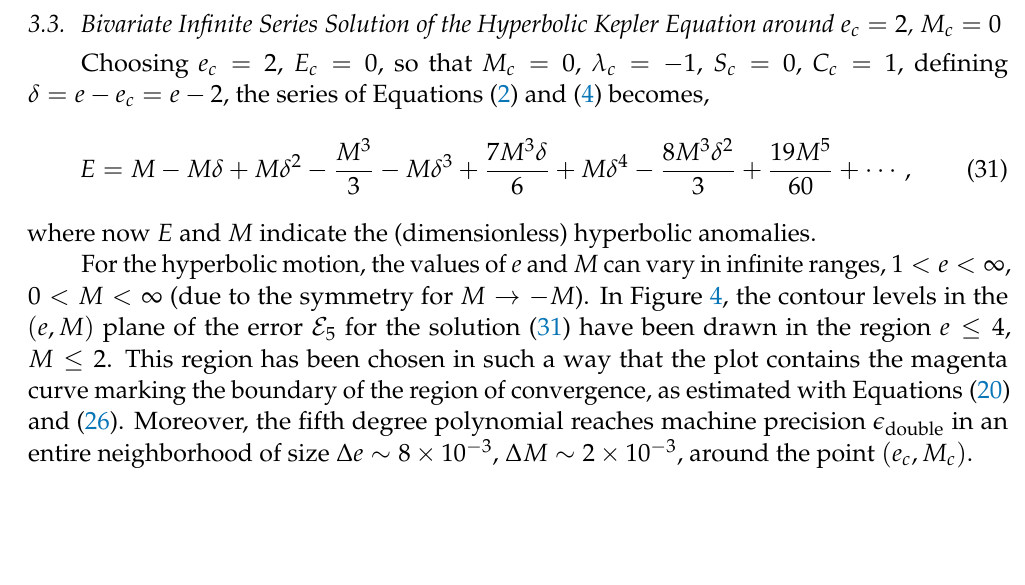
Figure 3. Contour levels of the error E 5 affecting the fifth degree polynomial approximation of Equation (30), as a function of the eccentricity e and the mean anomaly M . The continuous magenta curve marks the boundary of the region of convergence, as estimated with Equations (20) and Equation (26). (Notice that here the axes for e and M are